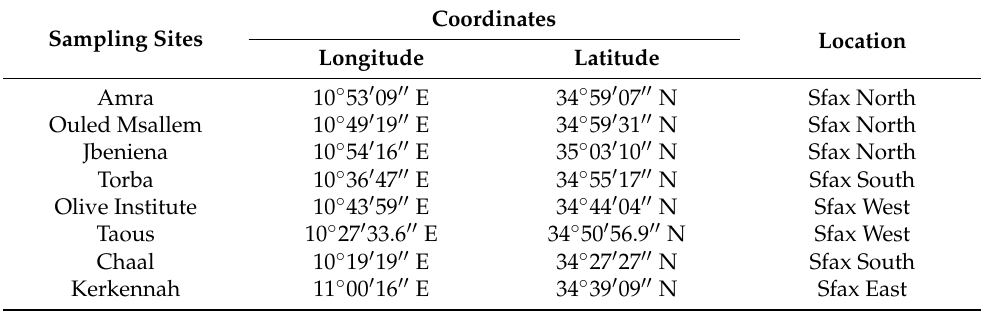
Table 1. Sampling sites and their